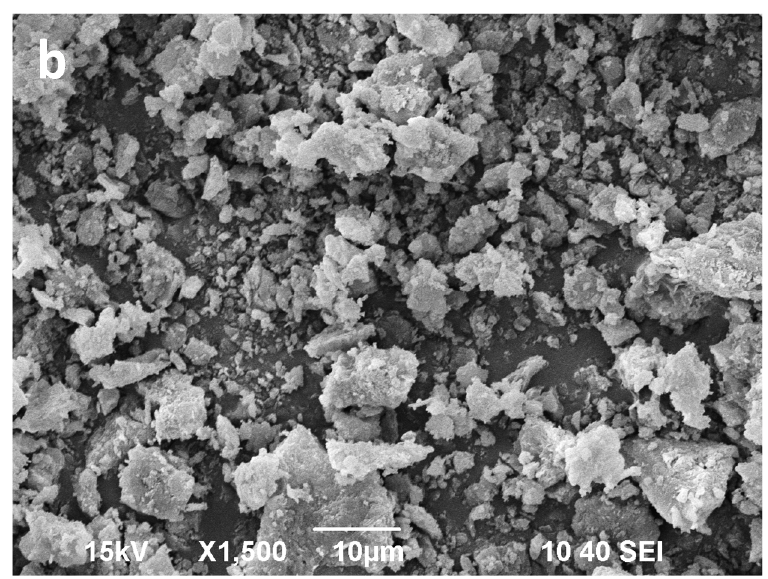
Figure 9. SEM images of the kerolite K2 ( a ) and kerolite K2 after 16 min of microwave-assisted acid treatment ( b ).